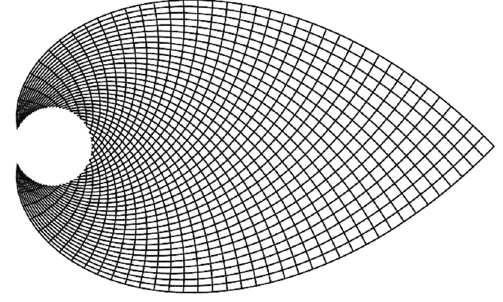
Figure 3. Dense mash solution in direction of principal stresses [8].